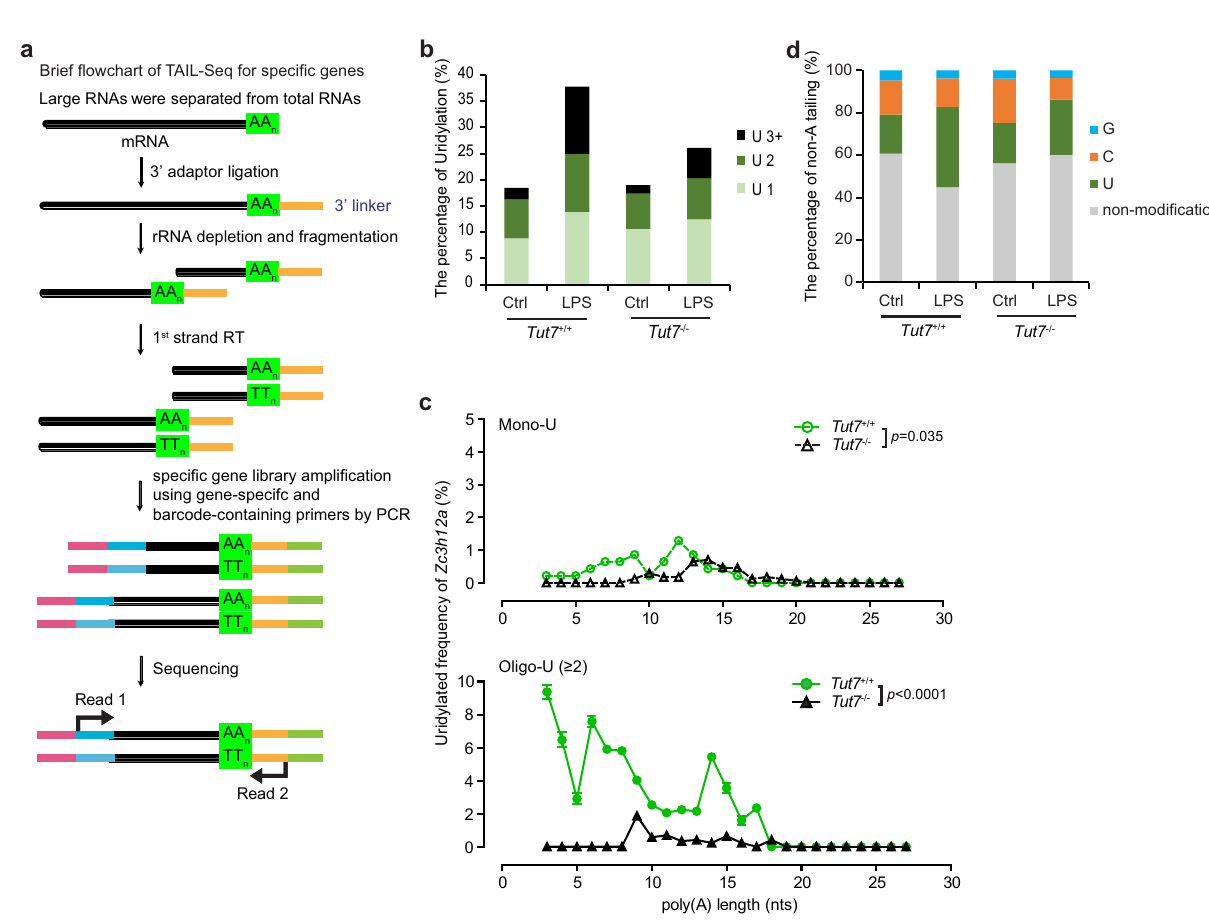
Fig. 6 TUT7 mediates oligo-uridylation of Zc3h12a on 3 ′ end in response to LPS. a Flowchart showing the experimental procedure of speci fi c gene TAIL- Seq to analyze 3 ′ tails of Zc3h12a mRNA transcripts. b The frequency of Zc3h12a uridylation assessed by speci fi c gene TAIL-Seq. Uridylation frequency is the percentage of uridylated Zc3h12a reads out of the total number of Zc3h12a reads. c the correlation between the mono-uridylation (upper panel) and oligo-uridylation (lower panel) of Zc3h12a and their poly(A) tail lengths. Uridylation frequency presents the percentage of uridylated reads among the total Zc3h12a reads. d The frequency of non-templated 3 ′ end modi fi cations on Zc3h12a tails. The Y -axis presents the percentage of uridine, cytosine, and guanine additions among total Zc3h12a reads (for cytosine and guanine additions, 75 and 22 among 466 reads, 144 and 40 among 1067 reads, 65 and 12 among 311 reads, and 174 and 60 among 1714 reads in Tut7 + / + , Tut7 + / + ( + LPS), Tut7 − / − , and Tut7 − / − ( + LPS) cells, respectively. The value of uridylation is from b ). The p value in ( c ) was assessed by Pearson correlation analysis. Source data are provided as a Source Data fi